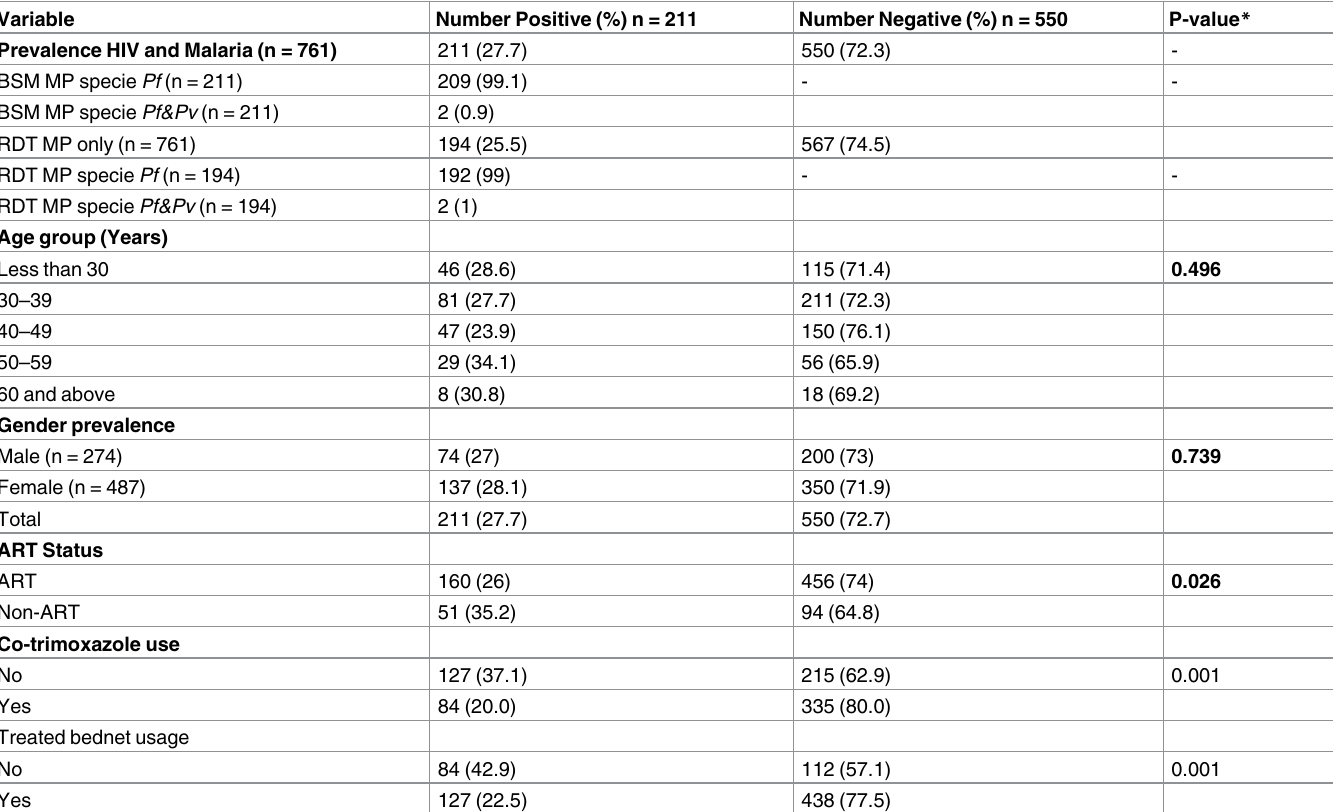
Table 3. Prevalence of HIV and Malaria Co-infection in Relation to Age, Gender. Cotrimoxazole and Treated bed net usageamong HIV Patients Attend- ing ART Clinic at Infectious Disease HospitalKano BetweenJune to December2015 (n = 761).